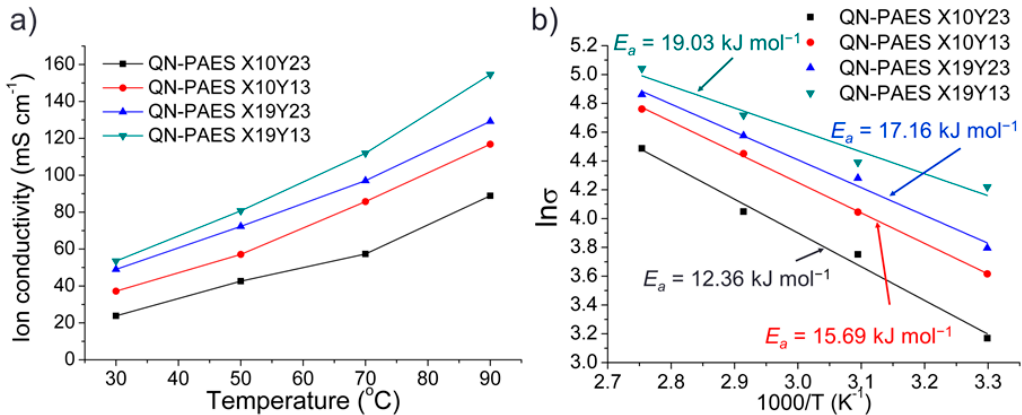
Figure 9. ( a ) The hydroxide conductivity of QN-PAES membranes and ( b ) Arrhenius plot of QN-PAES membranes at various temperatures under 100% RH.